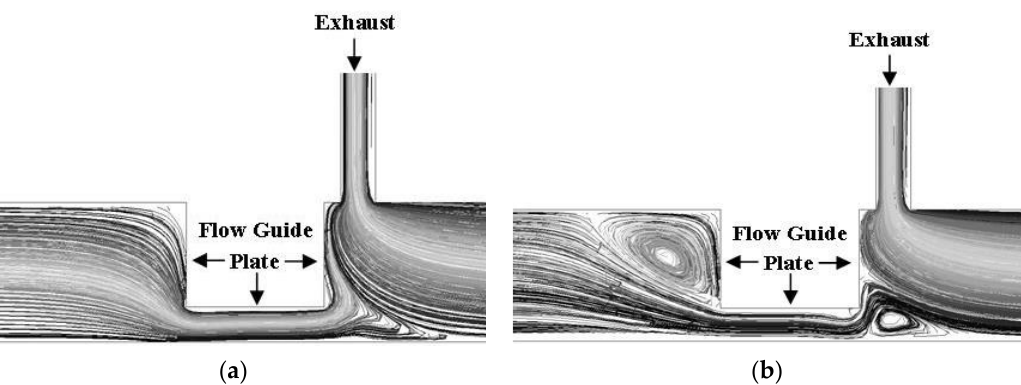
Figure 7. Material utilisation calculated using (1) for S-1 – S-4 configurations. 4.2. Dynamic Mode – Deposition Kinetics A series of CdTe thin films were grown using the S-1 configuration, with F Total = 1.0 l/min and v sub = 1.8 cm/min, where only T s was varied in order to correlate the kinetic regime of the pyrolysis of CdTe layer with CFD simulations (Figure 8a). The activation energy ( E a ) of the surface kinetic reaction was calculated from Equation (8) using the linear range from the Arrhenius plot in Figure 8a.